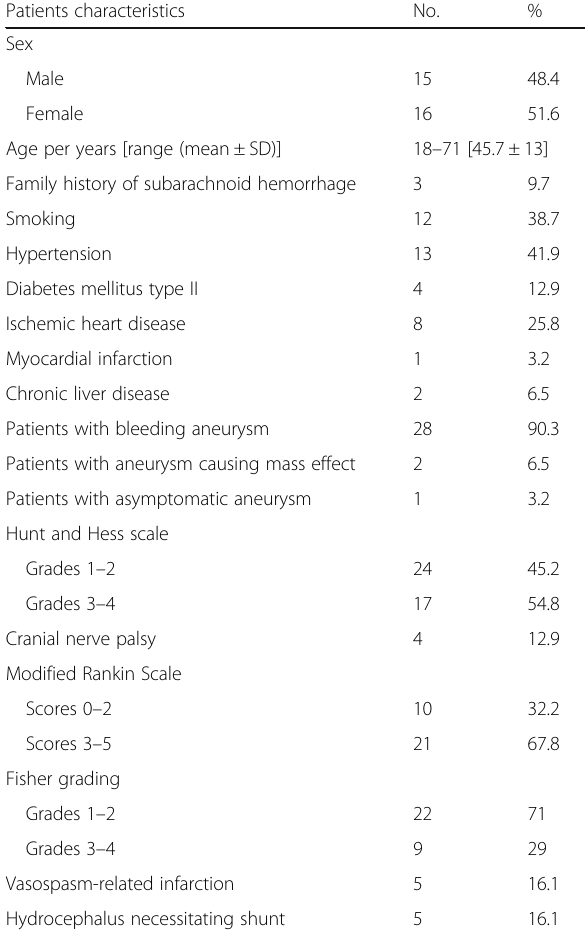
Table 1 Patients characteristics and initial clinical evaluation Patients